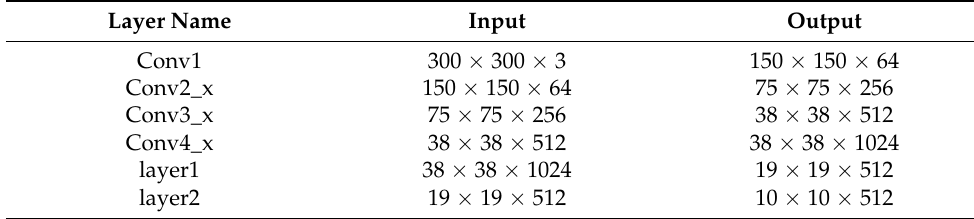
Table 1. Input and output dimensions of each